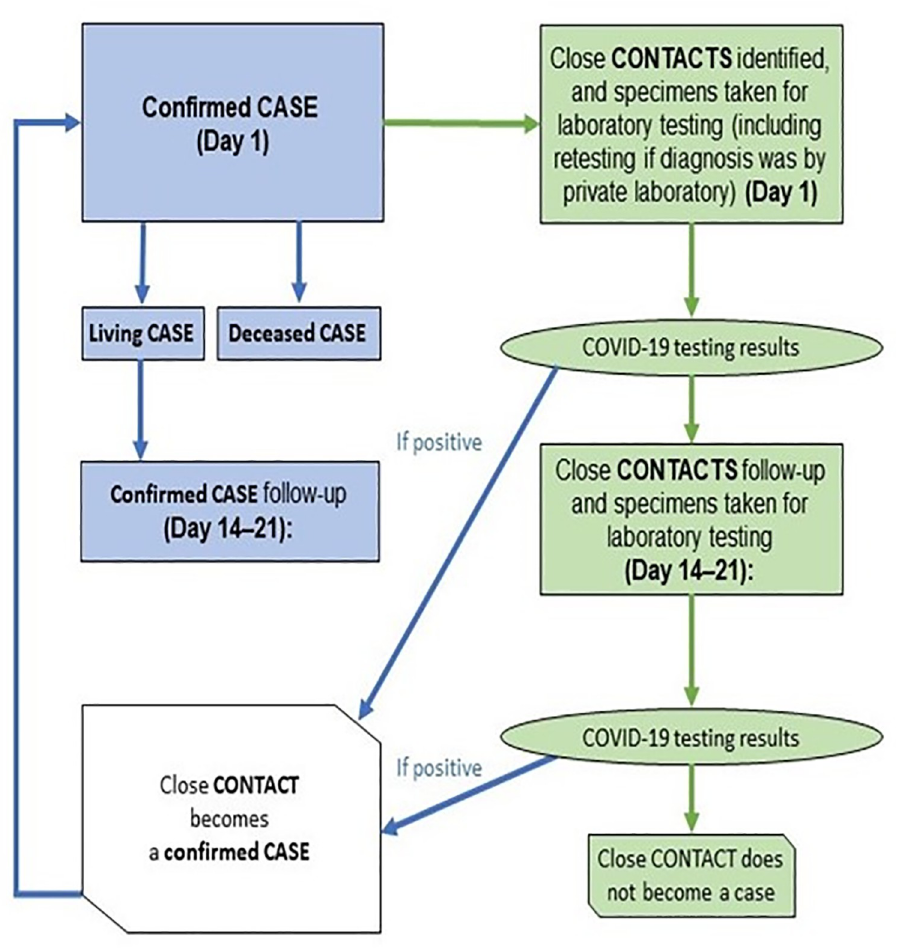
Fig 1. Study flow for the first few cases of COVID-19 in Kisumu, Kenya, June-October 2020.